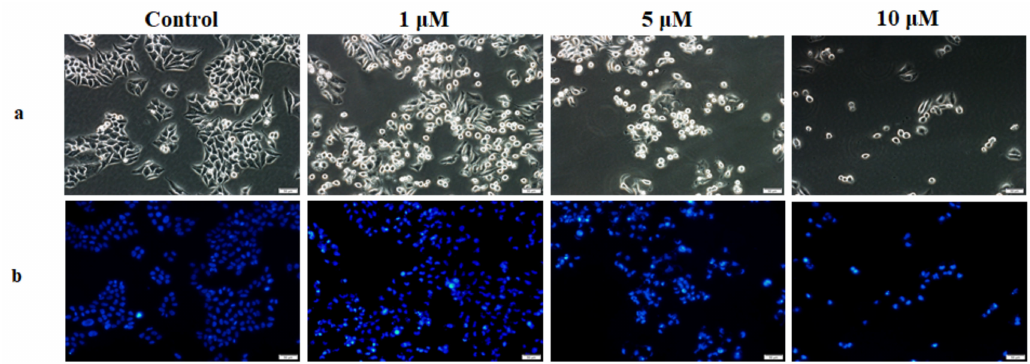
Figure 1. HepG2 cells morphological changes ( a ) and Hoechst 33342 staining ( b ) after treated with compound 8a (1, 5, 10 µ M) for 24 h. Scale bar, 50 µ m.